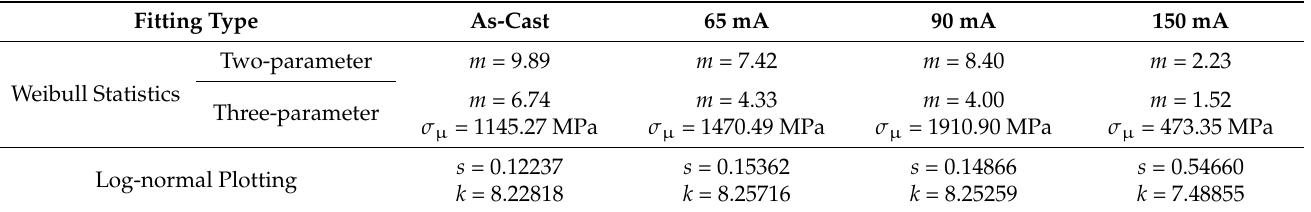
Table 2. Fracture reliability parameters of as-cast and direct current-annealed Co-based metallic